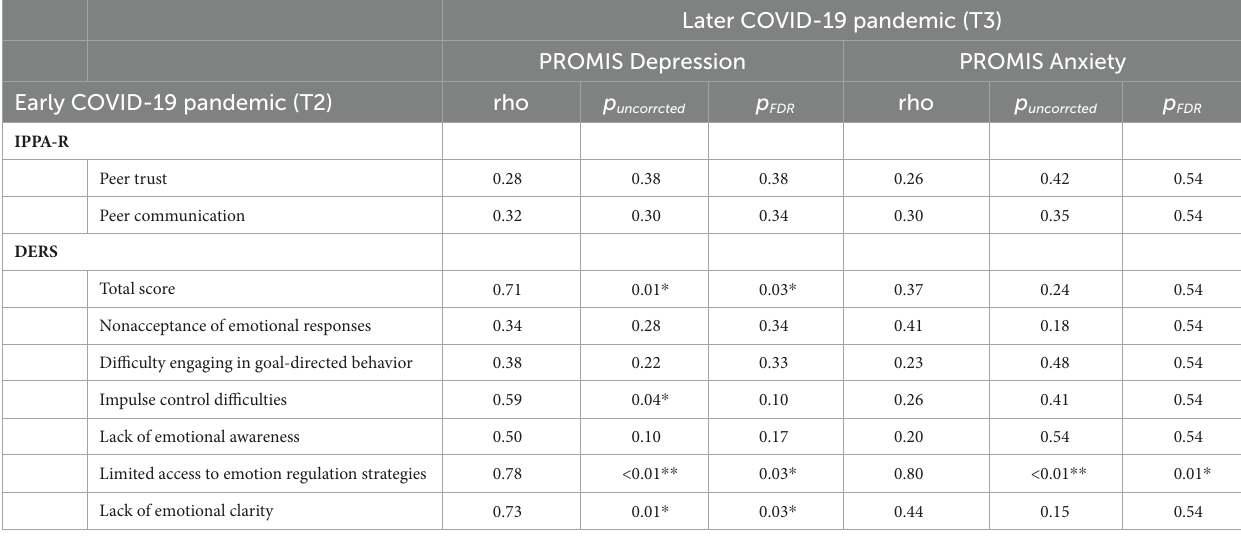
TABLE 3 Spearman’s partial correlations between difficulties in emotion regulation at the early pandemic (T2) and depression/anxiety severity at the later pandemic